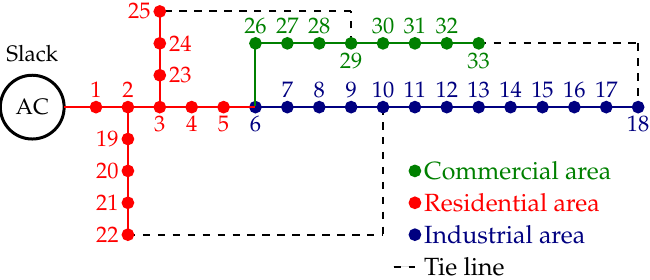
Figure 3. Schematic meshed configuration of the IEEE 33-bus grid with load classifications.